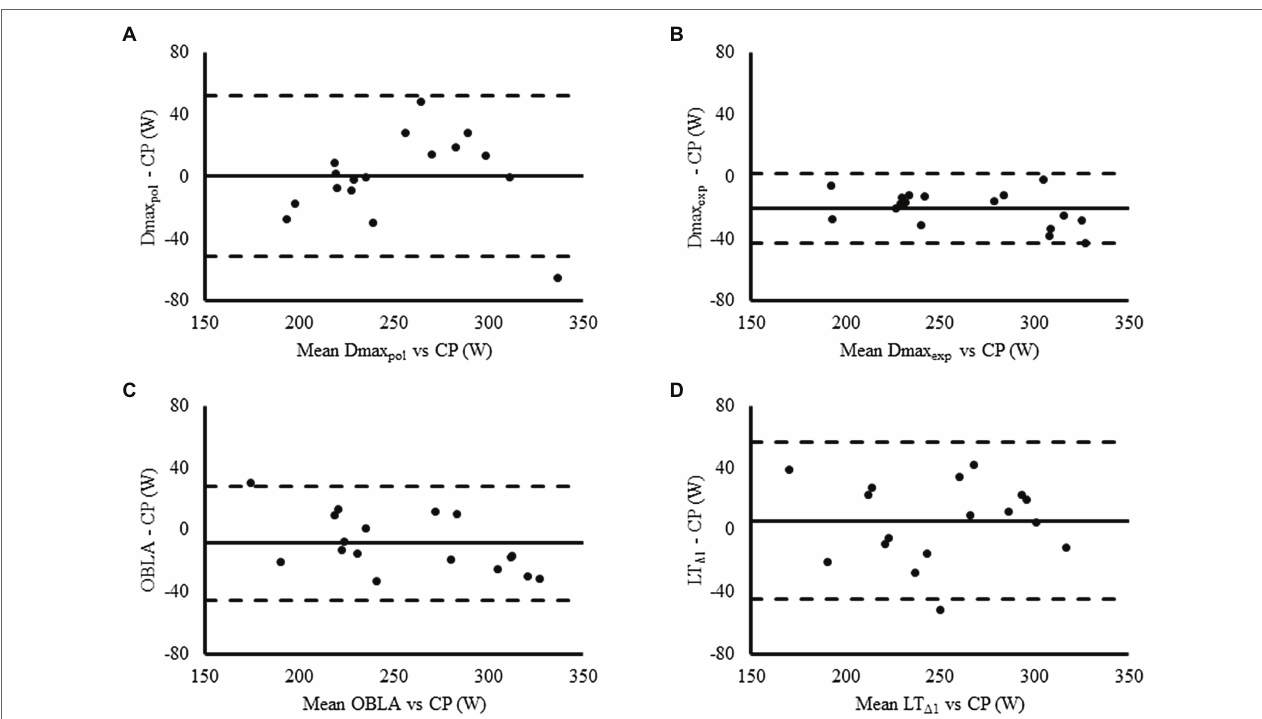
FIGURE 3 | Bland–Altman plot displaying the agreement between each lactate threshold marker and critical power [Dmax exp (A) , Dmax pol (B) , OBLA (C) , and LT Solid and dashed horizontal lines represent the bias and the limits of agreement (bias ± 1.96 SD), respectively.